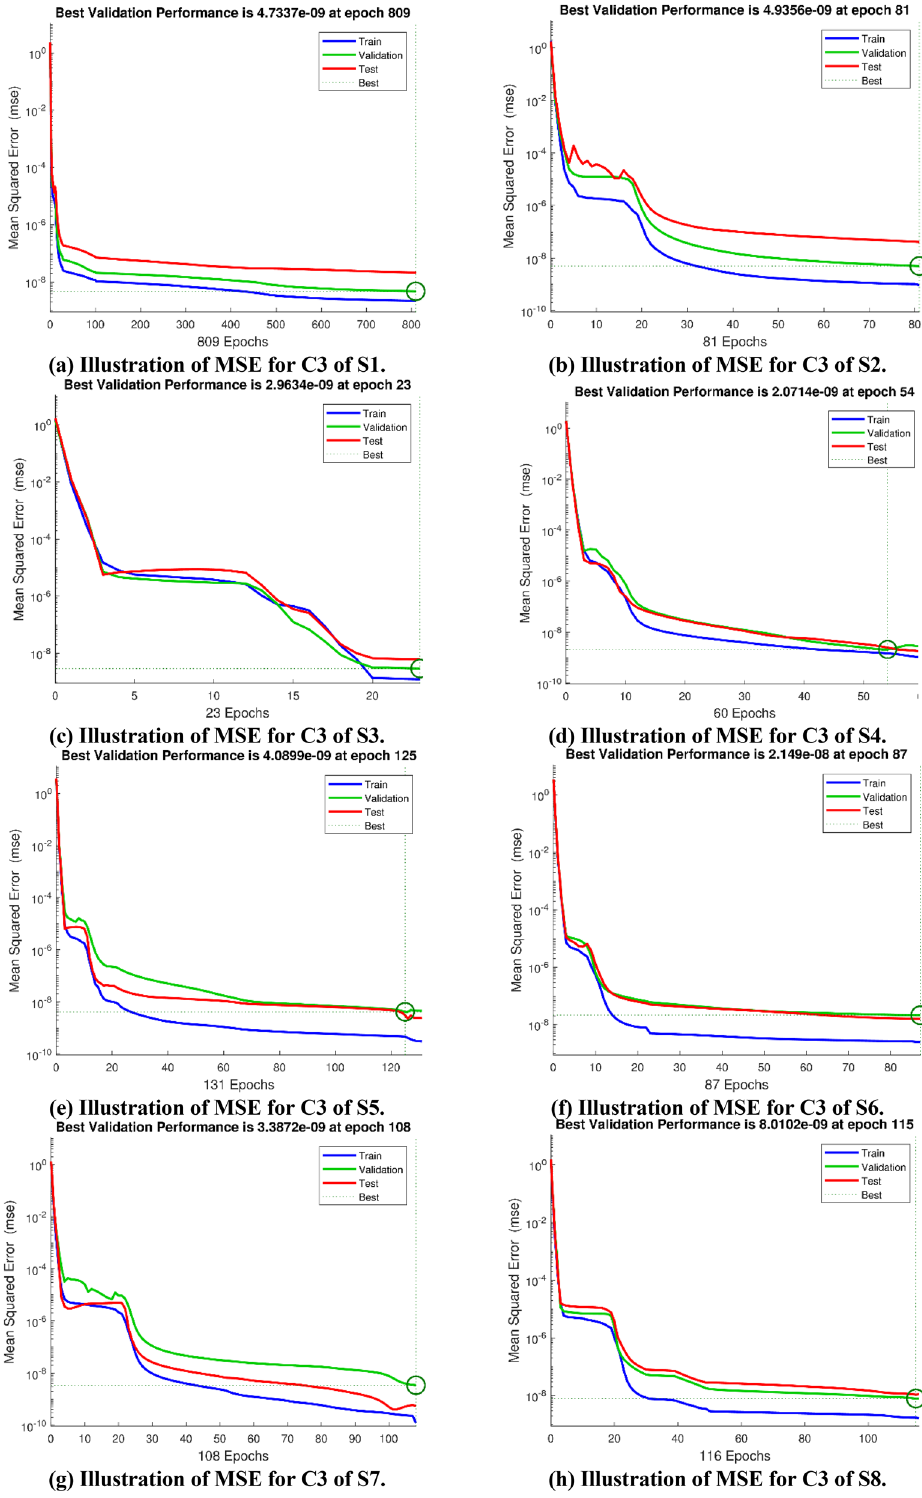
Figure 5. Performance illustration through graphs of C3 of all eight